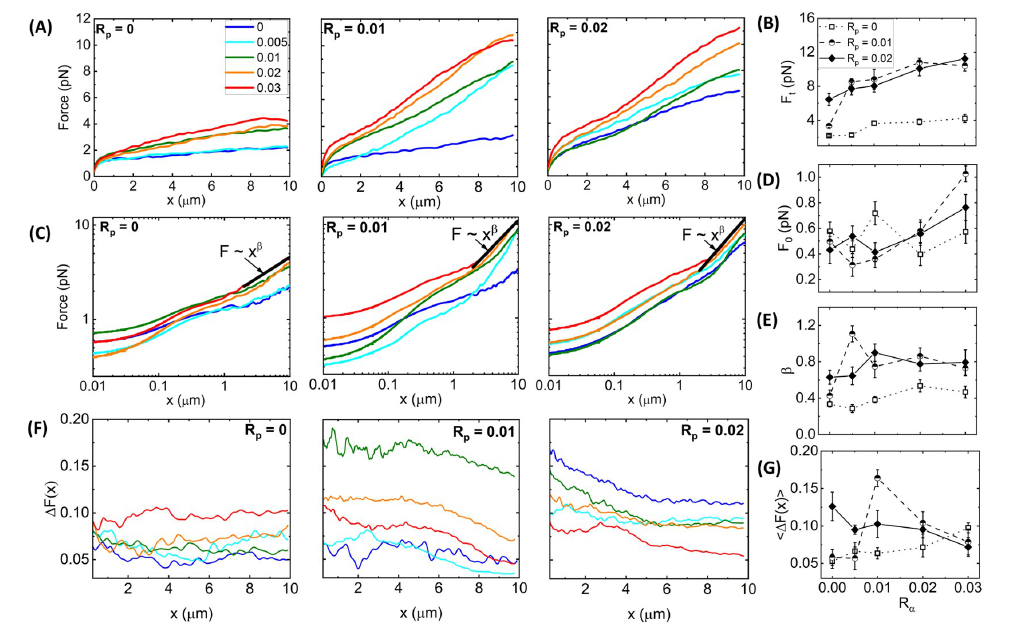
Figure 3. Synergistic effects of crosslinking and stabilization enable sustained elastic response of actin networks to nonlinear straining . ( A ) Force F ( x ) versus stage position x measured for actin networks subject to nonlinear straining (see Figure 1). Different curves in each panel correspond to α -actinin:actin molar ratios of R α = 0–0.03, color-coded according to the legend in ( A ). Different panels display data for phalloidin:actin molar ratios of R p = 0 ( left ), R p = 0.01 ( middle ), and R p = 0.02 ( right ). ( B ) Terminal force reached at the end of the strain F t as a function of R α for R p = 0 (open squares, dotted connecting lines), R p = 0.01 (half-filled circles, dashed connecting lines), and R p = 0.02 (solid diamonds, solid connecting lines). ( C ) Data shown in ( A ) plotted on a log–log scale to highlight the trends seen for the initial force F ( x = 0 ) = F 0 and power-law scaling of F ( x ) near the end of the strain ( x ≈ 1). Fitting the large strain data to a power-law F ( x ) ∼ x β yields the scaling exponent β that quantifies the degree of elastic storage maintained at the end of the strain. ( D ) Initial force measured at the beginning of the strain F 0 and ( E ) power-law scaling exponent β determined from fits to F ( x ) ∼ x β depicted in ( B ) versus R α for R p = 0 (open squares, dotted connecting lines), R p = 0.01 (half-filled circles, dashed connecting lines), and R p = 0.02 (solid diamonds, solid connecting lines. ( F ) Fractional spread in force ∆ F ( x ) for each position x and each condition, determined by computing the standard error across 30 individual trials and normalizing by the average value plotted in ( A ): ∆ F ( x ) = SE (cid:104) F ( x ) (cid:105) . ( G ) ∆ F ( x ) averaged over the strain position x , resulting in a single value for F / each curve shown in ( F ) with error bars denoting the standard error across x values. Error bars shown in ( B , D , E ) represent the standard error of values computed from the 30 individual trials that comprise each average force curve shown in ( A